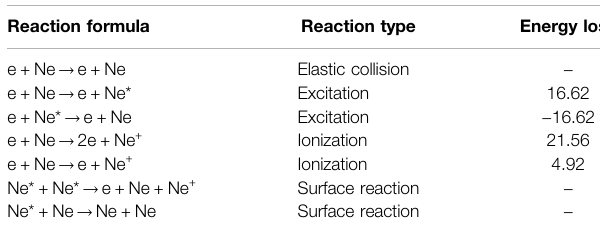
TABLE 1 | Reaction formulas and reaction types in discharge process of neon gas.